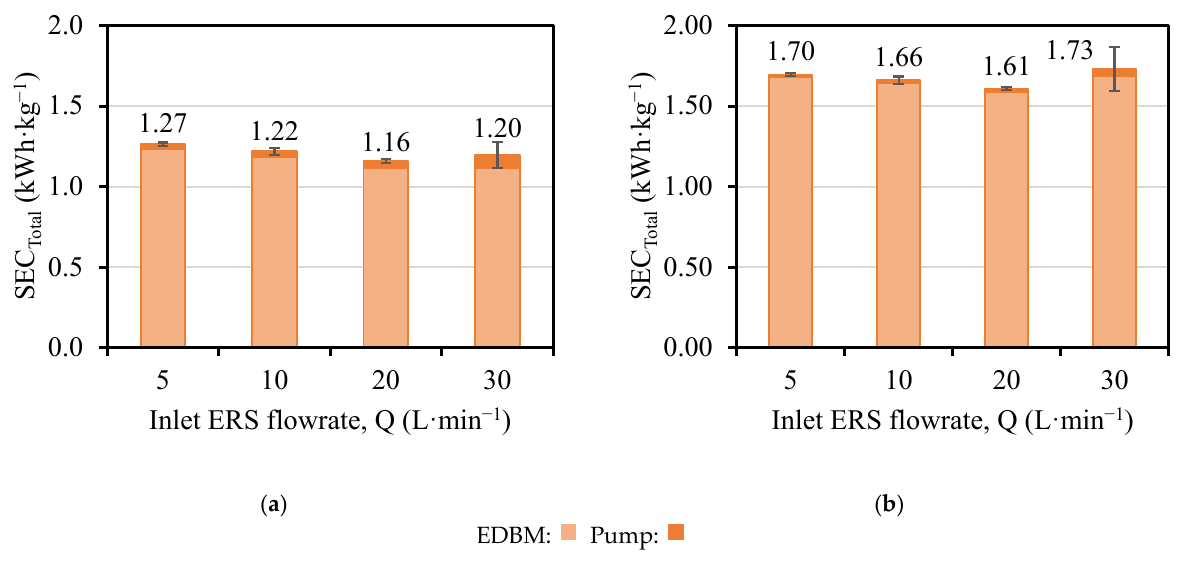
Figure 10. SEC Total versus the flowrate and as a function of the applied current density ( a ) T ‐ 200 ‐ I ‐ ERS; ( b ) T ‐ 400 ‐ I ‐ ERS.